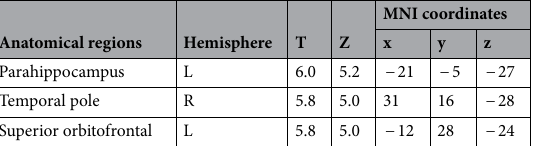
Table 3. White matter differences between Pandits/priests and control based on VBM analysis (Pandit > control).